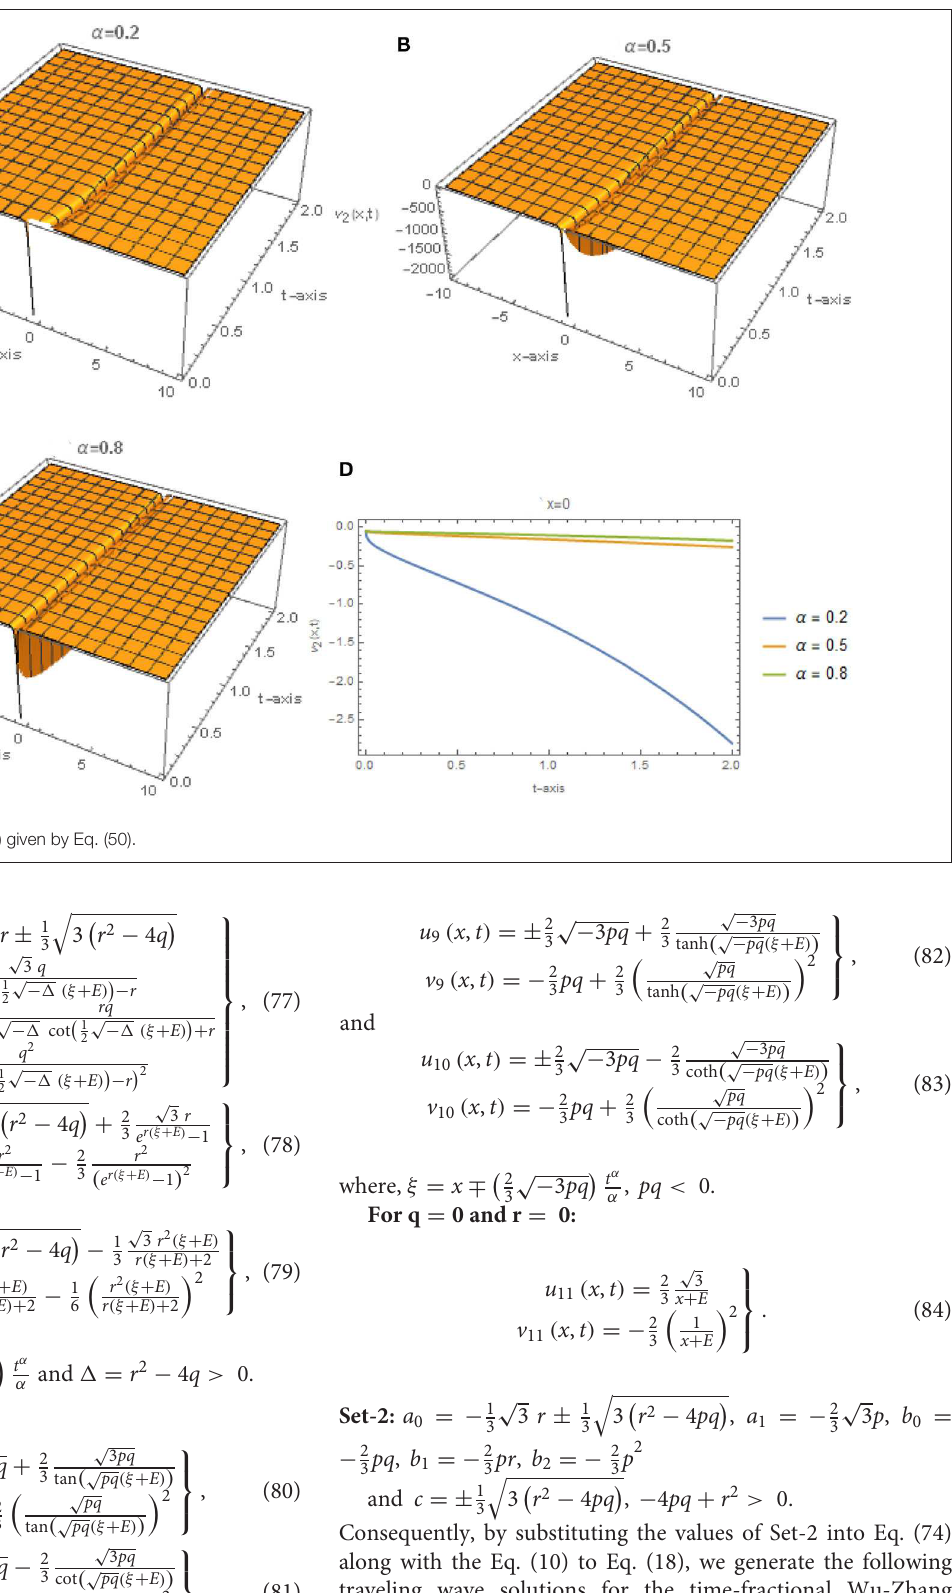
Consequently, by substituting the values of Set-2 into Eq. (74) along with the Eq. (10) to Eq. (18), we generate the following traveling wave solutions for the time-fractional Wu-Zhang system of